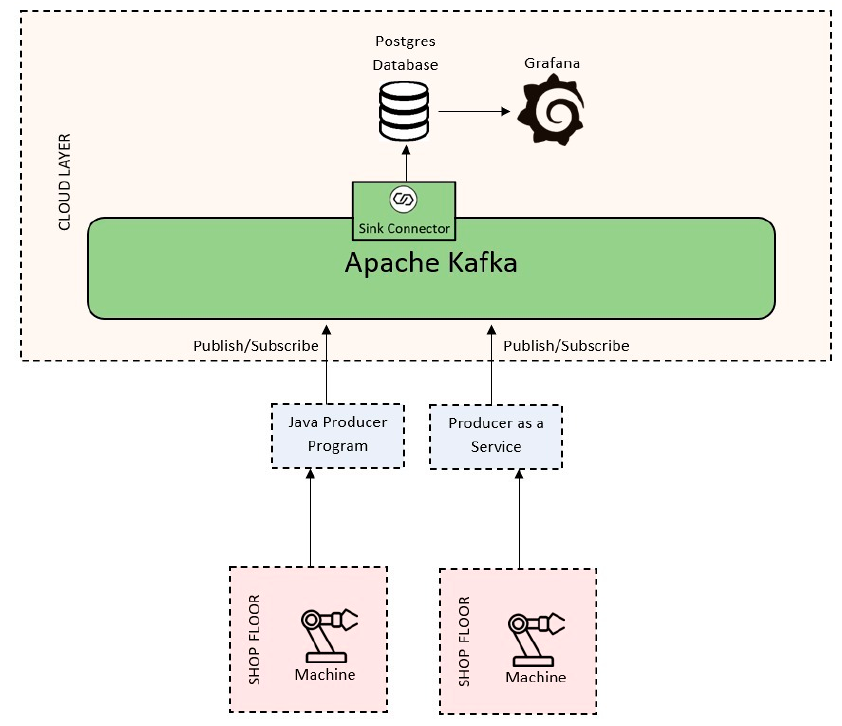
Figure 7. Implementation Overview.